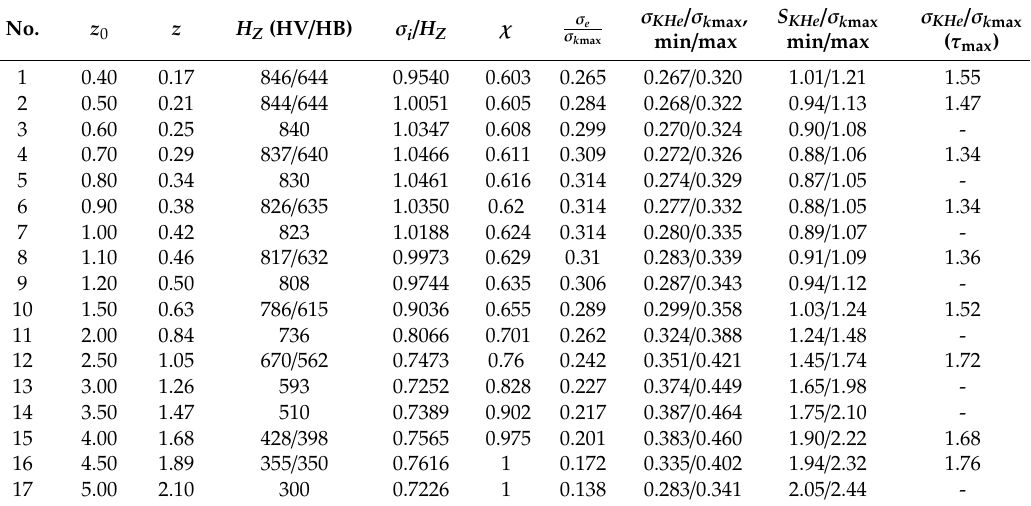
( b ) Figure 9. DCS CB ‐ 60 sample: a ) the amplitude of the ratio of octahedral stresses to hardness; b ) current and permissible equivalent stress: (1) equivalent stress; (2) minimum allowable stress according to the DCS criterion; (3) maximum allowable stress according to the DCS criterion. The calculations showed important features of the CD ‐ 30 and CB ‐ 60 samples. 1) For С D ‐ 30 samples, the depth of the crack initiating DCS of this sample is about 0.15 mm (Figure 6). The fracture zone is in the area of maximum material strength; the load capacity of the part is limited by the strength of the diffusion layer itself. The deep contact strength of the samples is not provided. It is necessary to introduce a safety factor according to the DCS criterion KHe S is in good agreement with the average depth of contact fractures С D ‐ 30 samples. The presence of only one local maximum makes it possible to focus on the largest value of the coefficient 2 K . 3) The actual fracture area of the CD ‐ 30 samples corresponds to the predicted calculated depth interval.